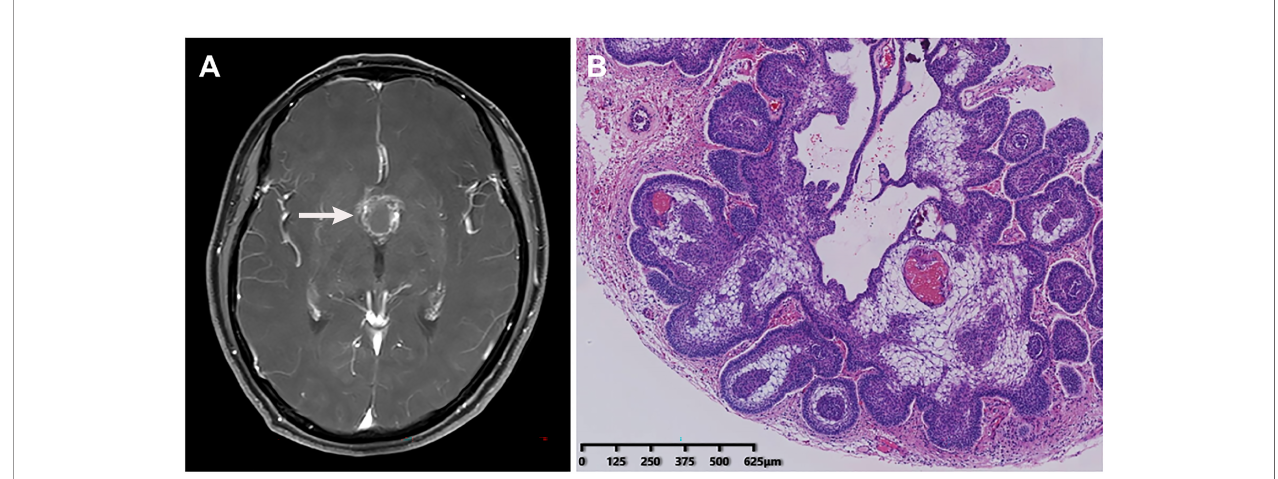
FIGURE 2 | Radiological imaging and histopathological examination of the patient. (A) Head magnetic resonance imaging showed a suprasellar space-occupying lesion. (B) Histopathological examination of a surgical specimen indicated adamantinomatous